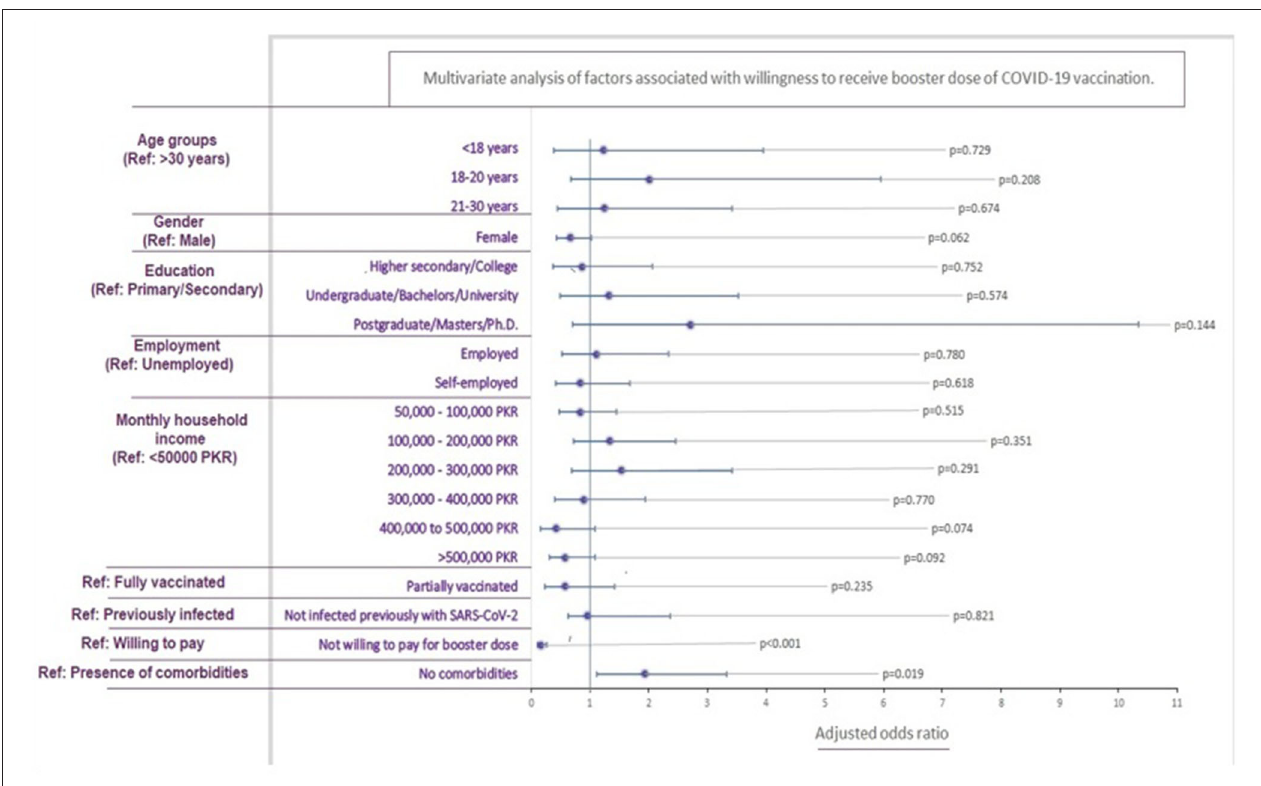
FIGURE 4 | Multivariable analysis of factors associated with willingness to receive booster